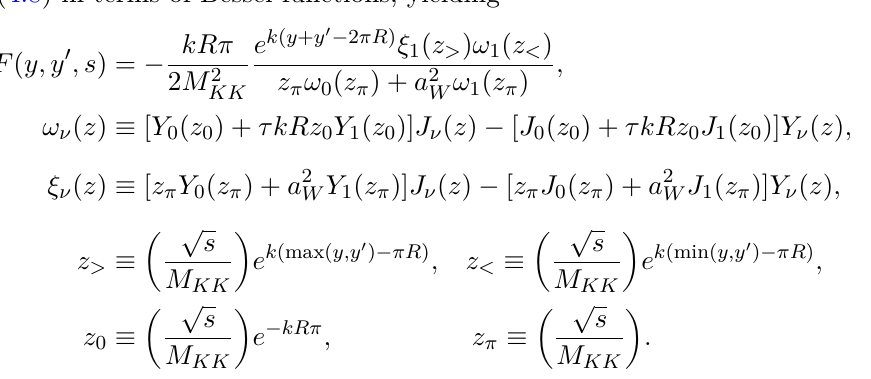
Figure 15 . (Top left) The approximate asymptotic value of | g n n , assuming kR = 1 . 5 , as a function of ( kR ) τ for various choices of a W = 3 (cyan), 5/2 (magenta), 2 (green), 3/2 (blue), 1 (red), 1/2 (yellow). (Top right) The same as the top left, but assuming kR = 2 . 0 (Bottom left) The approximate asymptotic value of | g n n , assuming kR = 2 . 0 , as a function of a W for various choices of ( kR ) τ = 3 (cyan), 5/2 (magenta), 2 (green), 3/2 (blue), 1 (red), 1/2 (yellow). The dashed line represents the maximum value that this ratio can obtain and still have all KK couplings remain perturbative for g D = 0 . 3 . (Bottom right) The same as the bottom left, but assuming kR = 2 . 0